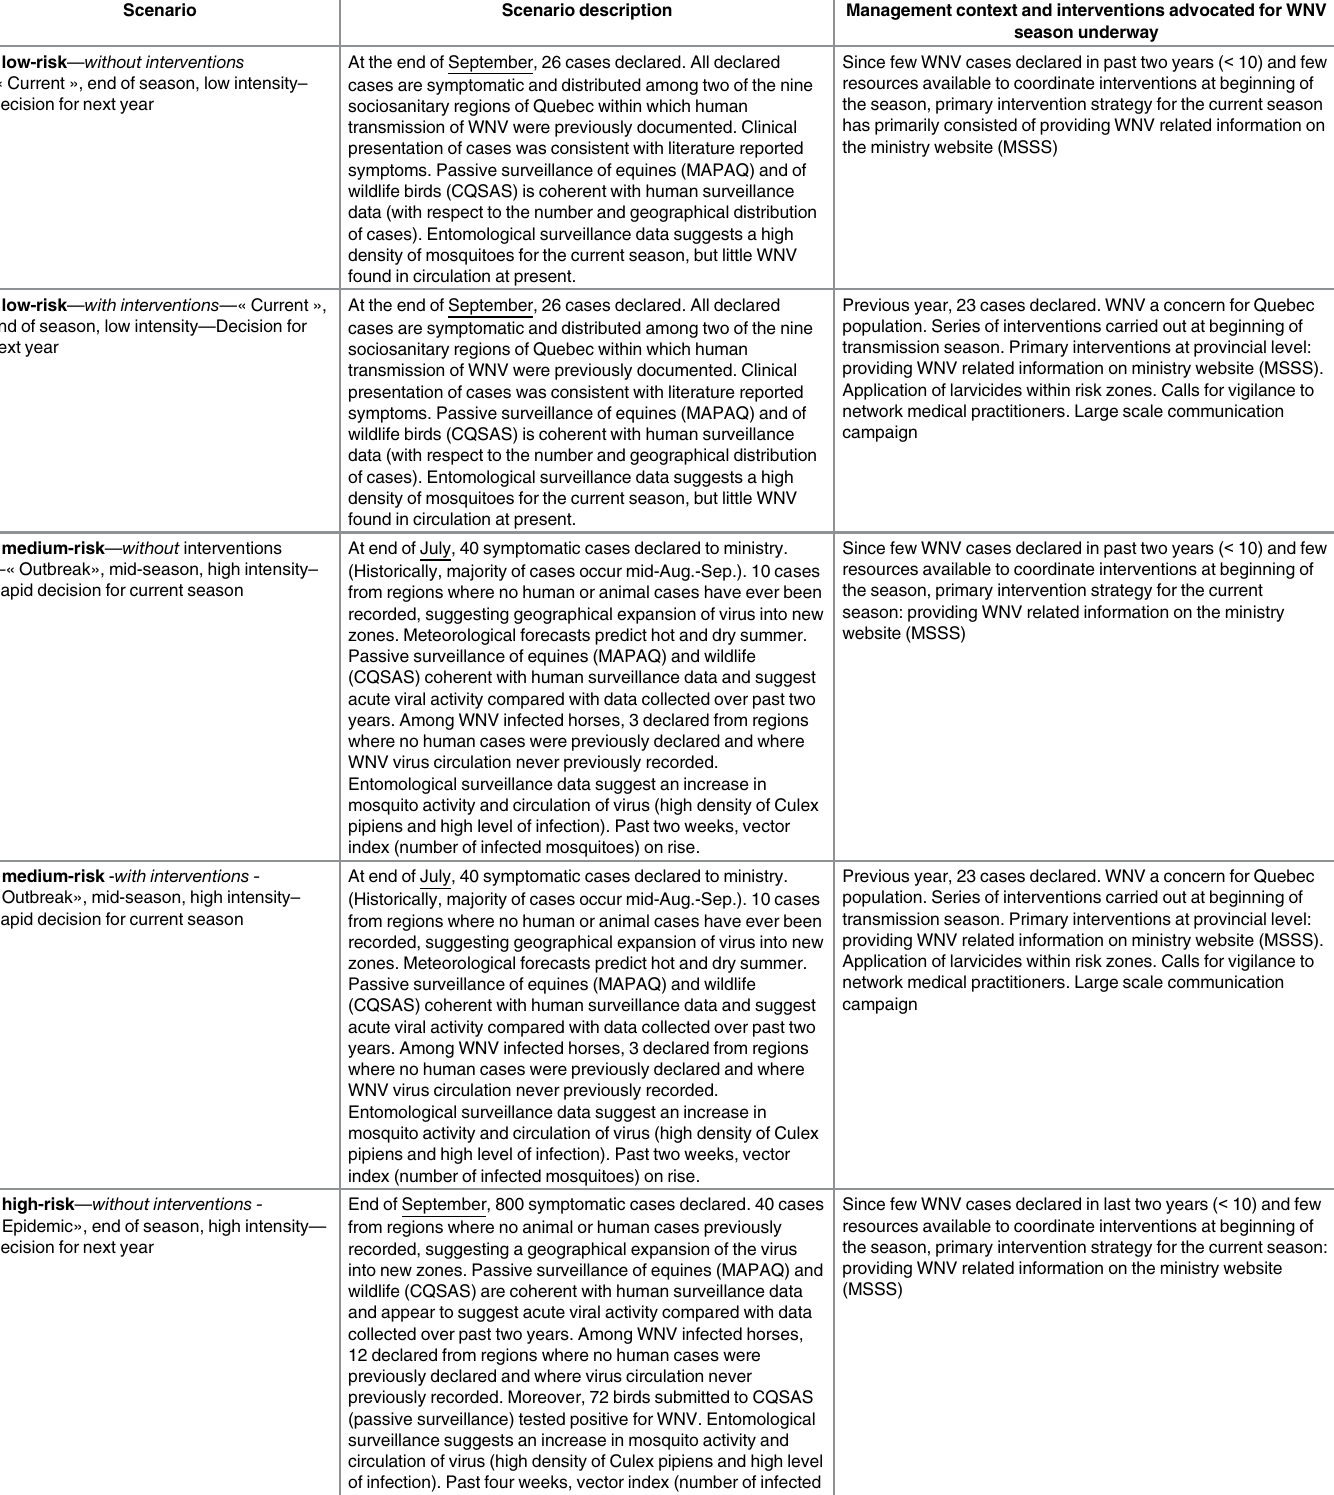
Table 1. Transmission risk scenarios assessed under the MCDA model for West Nile virus interventions in Quebec.